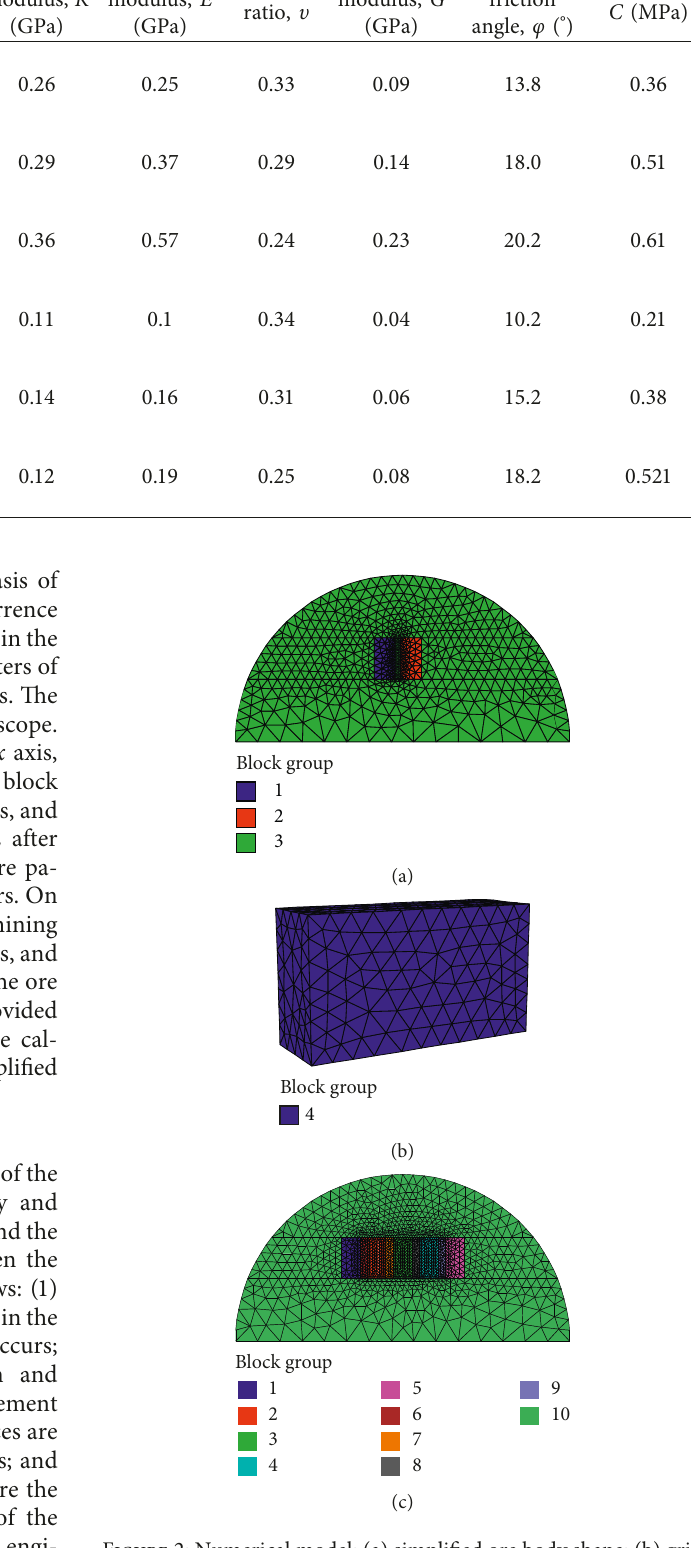
Figure 2: Numerical model: (a) simplified ore body shape; (b) grid model; (c) mining block